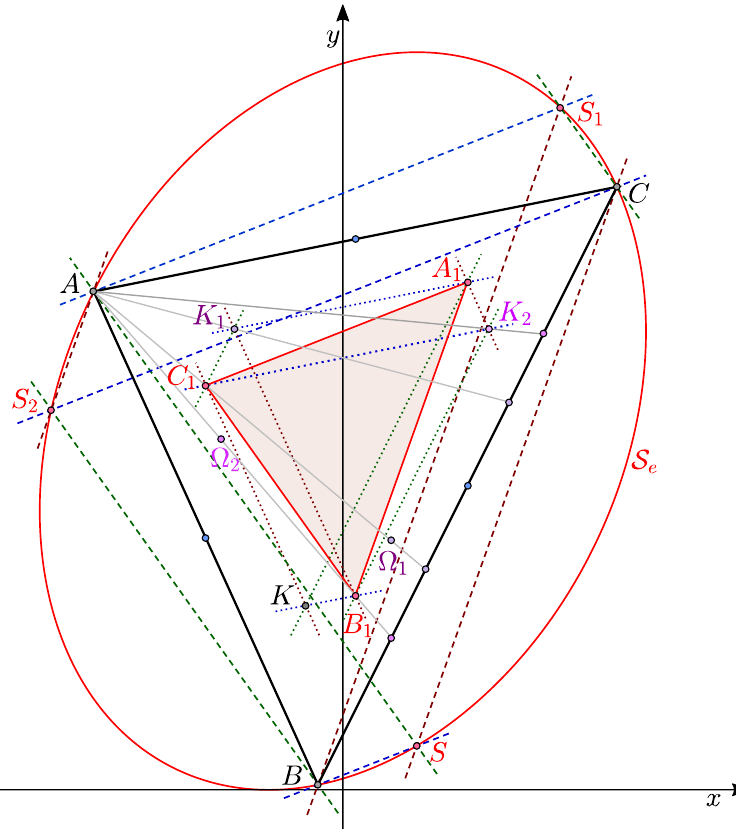
Figure 3. The circumscribed Steiner ellipse S e of the triangle ABC . Visualization of statements of Theorems